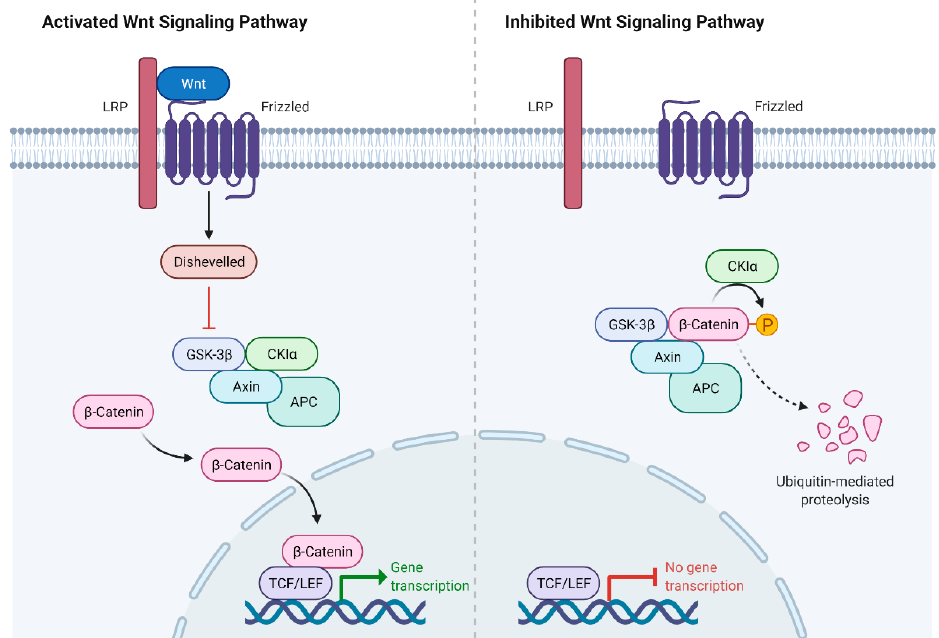
Figure 5. Canonical Wnt/β -catenin signaling pathway.